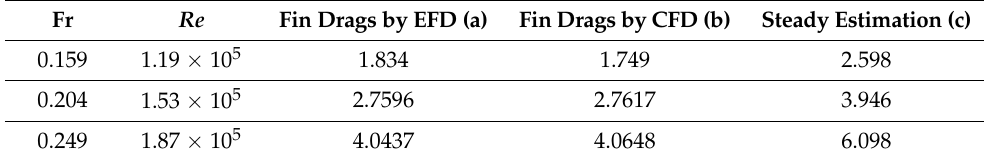
Table 6. Fin drag analysis at 20 ◦ in model scale (unit: N).